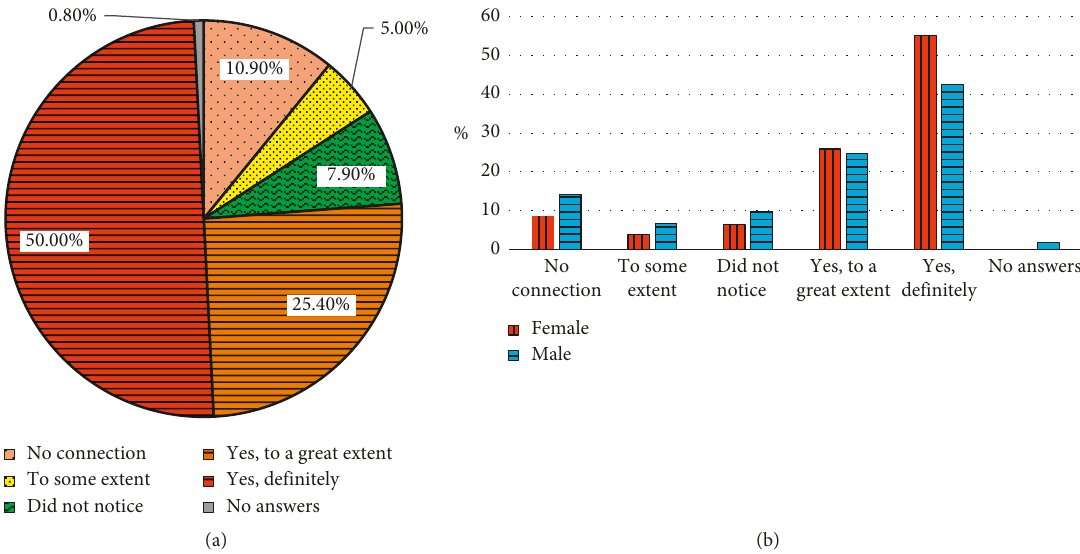
Figure 2: Perception of the influence of WeCos on rheumatic pain: all participants (a); by social gender (b)